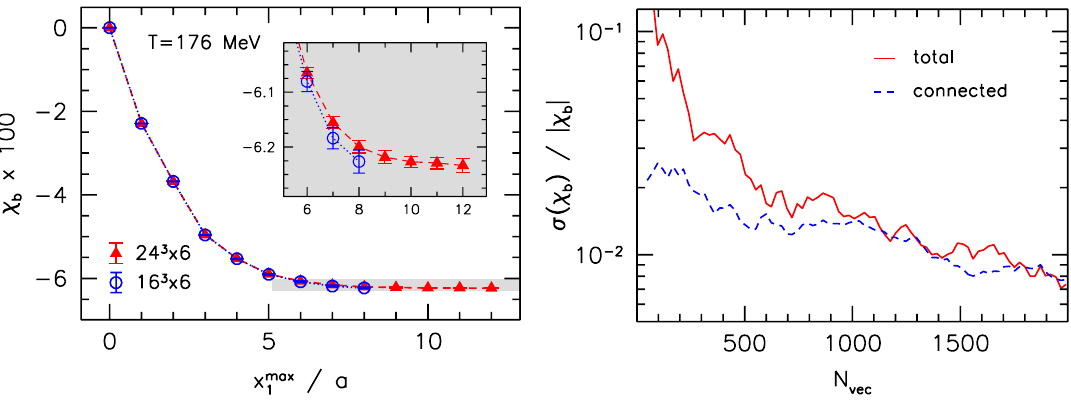
Figure 2 . Left panel: the susceptibility obtained via a truncation of eq. (3.7) for two di(cid:11)erent volumes, 24 3 (cid:2) 6 (red) and 16 3 (cid:2) 6 (blue). The inset zooms into the region near x max panel: relative error of the susceptibility as a function of the number of employed noisy